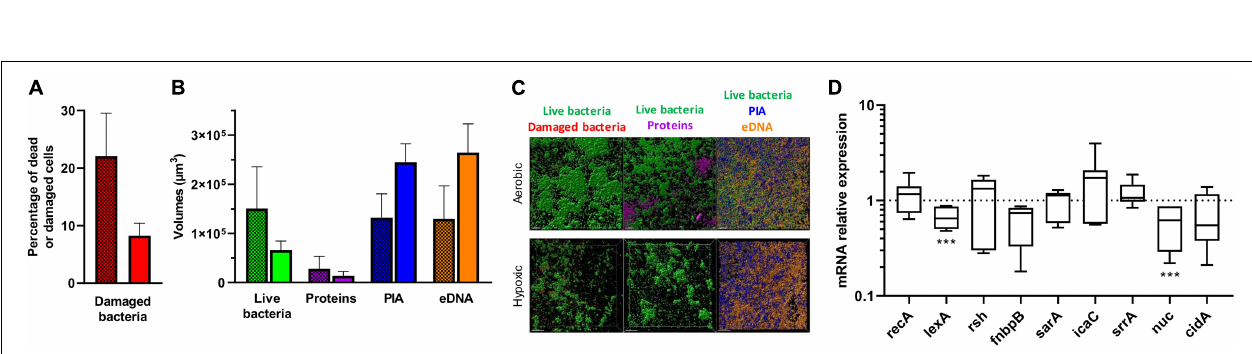
FIGURE 3 | Effect of hypoxia on matrix formation and gene regulation of S. aureus CIP 53.154. Biofilms were grown in minimal medium with or without oxygen for 24 h before staining and confocal laser scanning microscopy acquisitions or RT-qPCR analysis. (A) Results represent the percentage of dead or damaged bacteria (stained by PI) among live bacteria (stained by SYTO TM 9) acquired by confocal microscopy. Grid histograms represent biofilm growth with oxygen, whereas non-grid histogram represents growth without oxygen. (B) Results represent the volume measurement of SYTO TM 9 (green histograms, live bacteria), SYPRO R (cid:13) Ruby (magenta, protein), WGA (blue, PIA), and TOTO TM -3 (orange, extracellular DNA) acquired by confocal microscopy. Grid histograms represent biofilm growth with oxygen, whereas non-grid histogram represents growth without oxygen. (C) Representative images of confocal microscopy acquisitions are shown. The scale bars indicate 20 µ m. Experiments were performed two independent times with three representative acquisitions for each coverslip. (D) Results represented relative mRNA expressions of bacteria within biofilms grown hypoxically vs. those grown aerobically. Experiments were performed eight independent times with two technical replicates for each. Results are presented as box and whiskers: whiskers represent minimum and maximum, the bottom and top of the box are the 15th and 85th percentiles, and the black band inside the box stands for the median. Statistical analyses were performed using the exact non-parametric Wilcoxon–Mann–Whitney test for independent samples: ∗∗∗ Statistically different from aerobic culture condition ( p < 0.001).